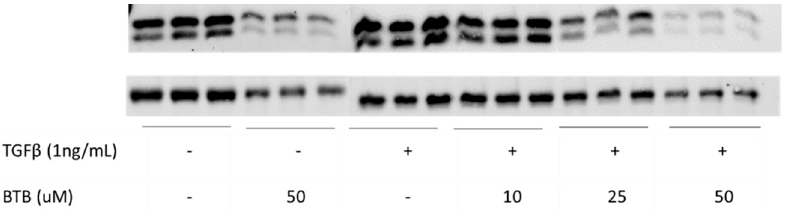
Figure 3. BTB inhibits myofibroblast differentiation in non-fibrotic and IPF-derived fibroblasts. Non-fibrotic and IPF-derived primary human fibroblasts were treated with the indicated dose of BTB and/or 1 ng/mL TGF β for 72 h before protein was harvested. Each graph represents an individual donor, and all experiments were performed with three non-fibrotic and three IPF-derived cell lines. Non-fibrotic fibroblasts were examined for the expression of α SMA ( A – C ) and calponin ( D – F ). IPF-derived fibroblasts were also examined for the expression of α SMA ( G – I ) and calponin ( J – L ). Data were analyzed by ANOVA. n = 3 technical replicates/group. * p < 0.05, ** p < 0.01, *** p < 0.001, **** p < 0.0001, ns= not statistically significant. Note for gels exceeding 15 samples that the first six lanes of each blot were run on a separately due to the lane capacity of the gel.